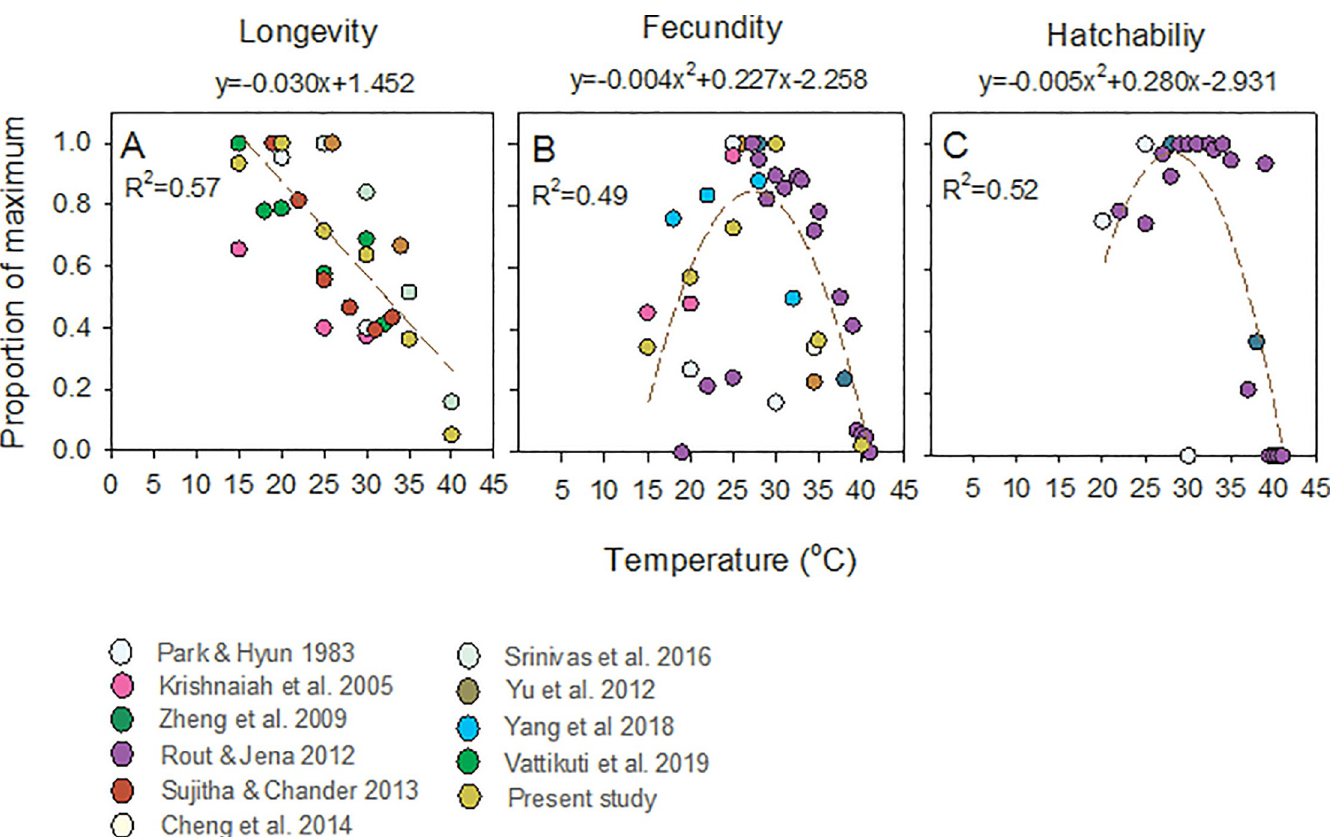
Fig 7. Temperature-dependent BPH (A) adult female longevity, (B) fecundity and (C) egg hatchability. Models are based on compiled published studies with means from the present study included. Lines, R 2 -values, and equations are for best fit models (based on averages at each temperature point [˚C]; i.e., data for the same temperatures from different studies are averaged). For A, where studies distinguished male and female longevity, only females were included. Colored symbols represent data sources as indicated (see also Fig 1). Data from Bae and Pathak [44] were excluded because the lowest temperature used was